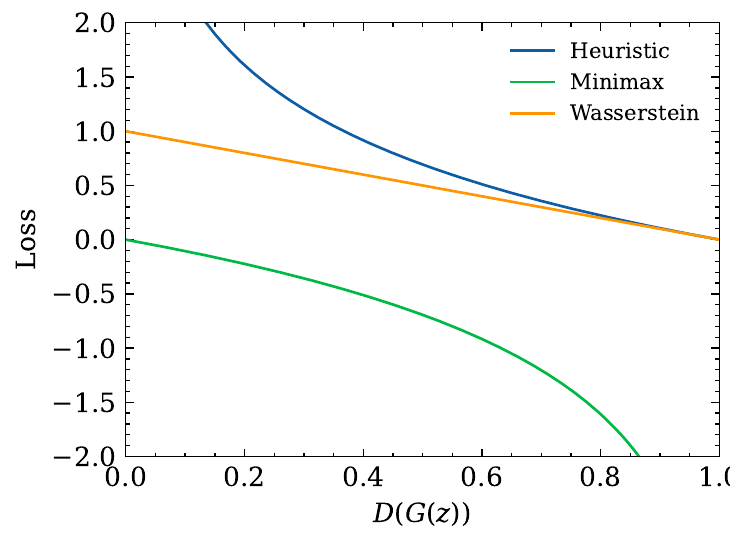
Figure 2. Function graphs for different objective